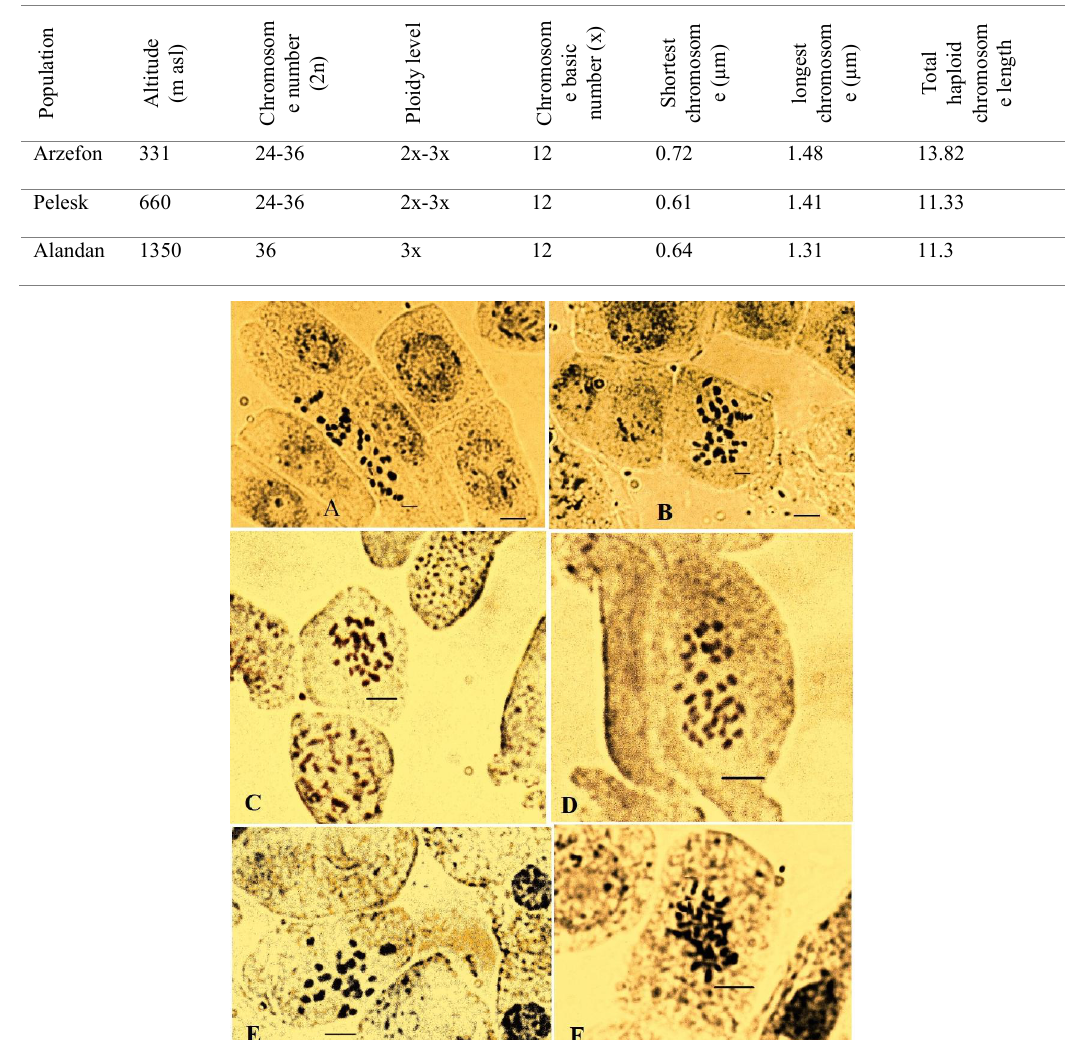
Table 2. Karyotype features of Iranian populations of Acorus calamus.